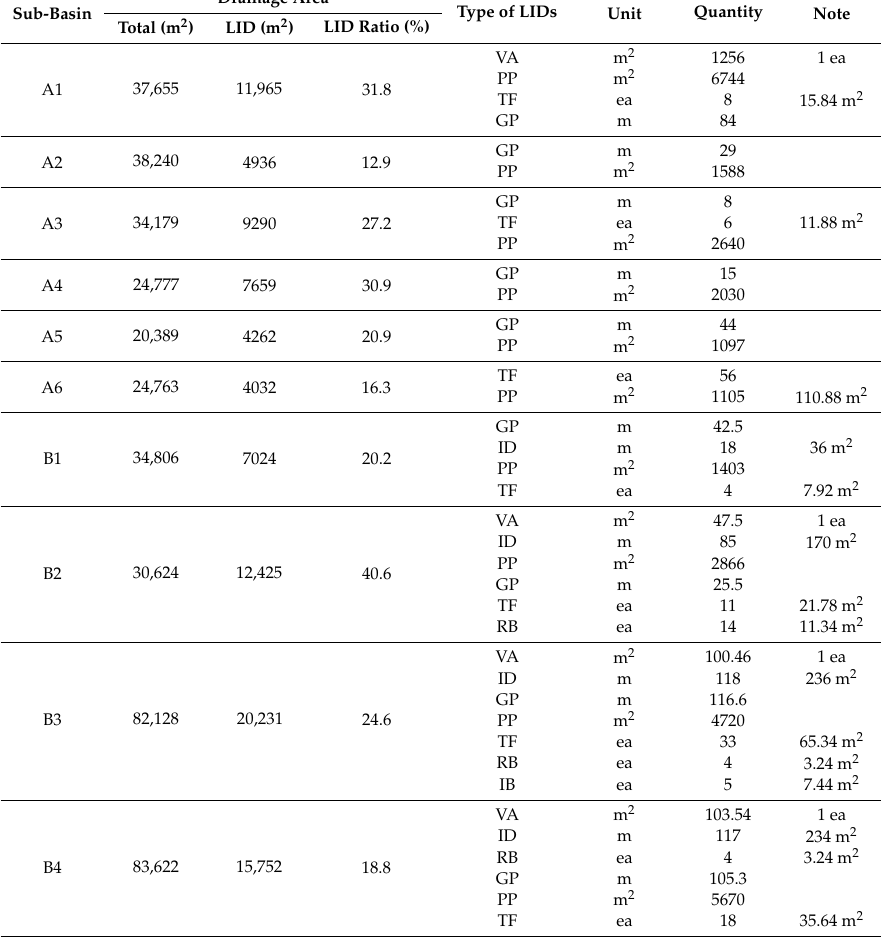
Table 2. Installation features of the LID facilities for each sub-basin: In this table, Total (m 2 ) and LID (m 2 ) indicate actual drainage areas for collecting a direct runoff into outlets at a sub-basin and entire LID facilities, respectively. LID Ratio (%) is a ratio of the LID (m 2 ) to the Total (m 2 ). In the unit column, ‘ea’ (or each) indicates a number of